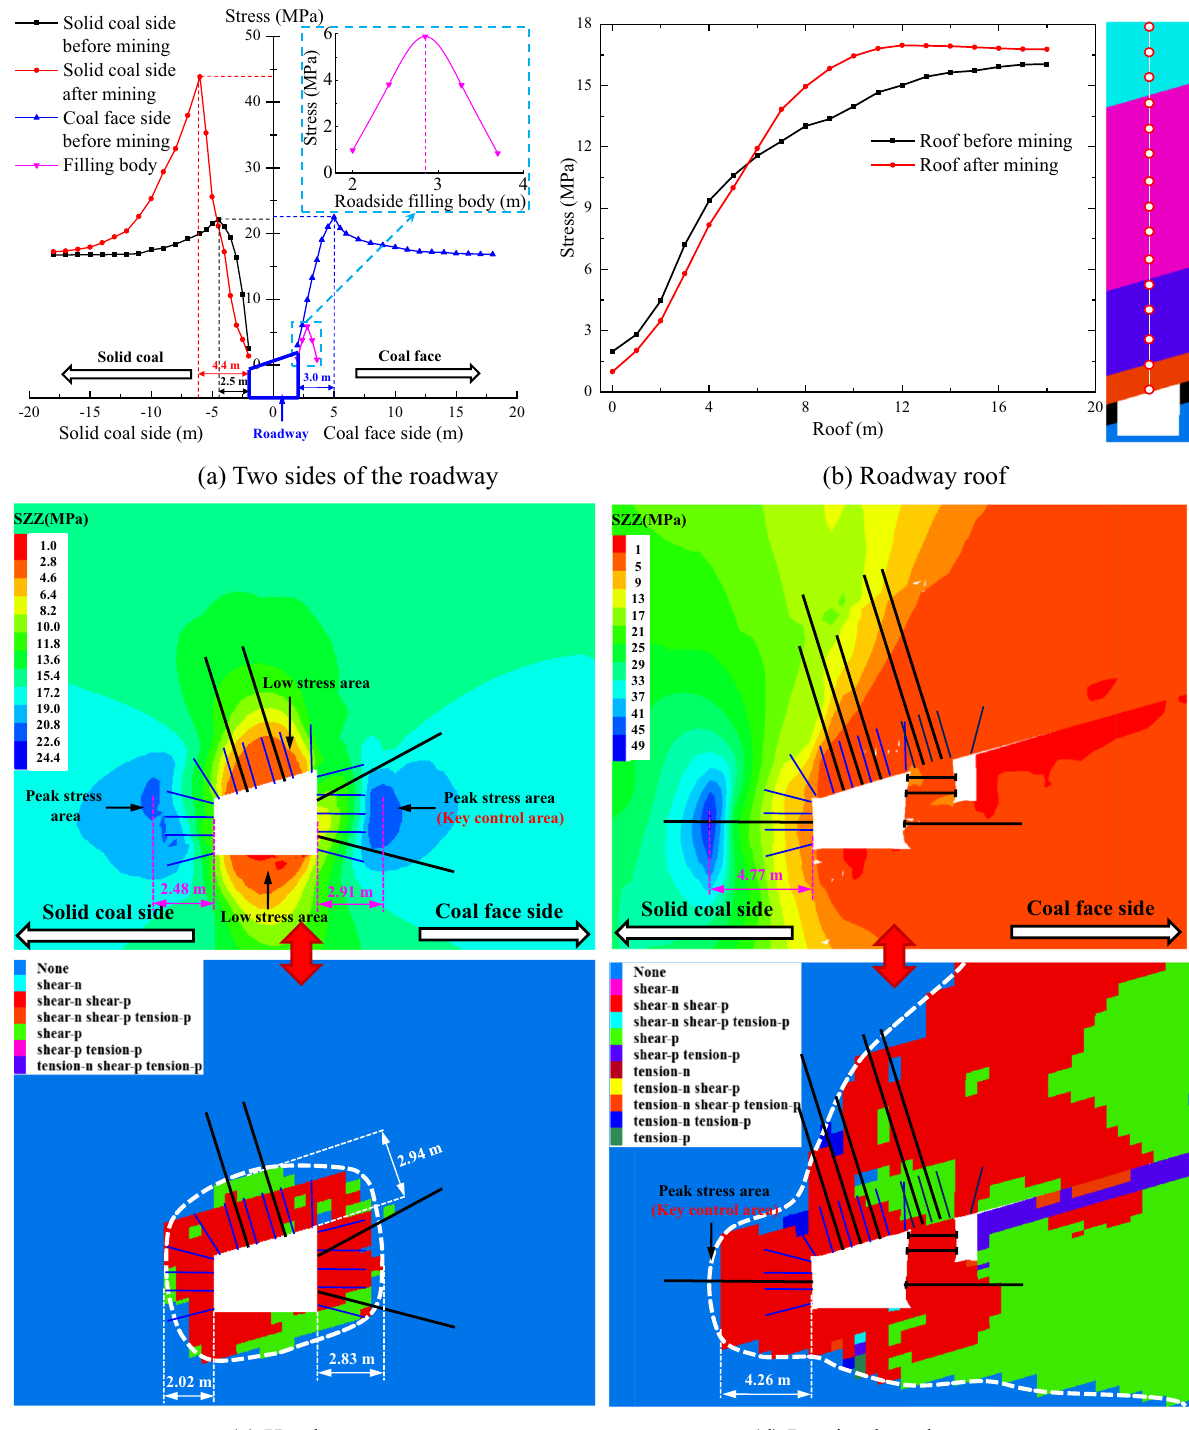
Fig. 11 Vertical stress and plastic zone distribution of roadway surrounding